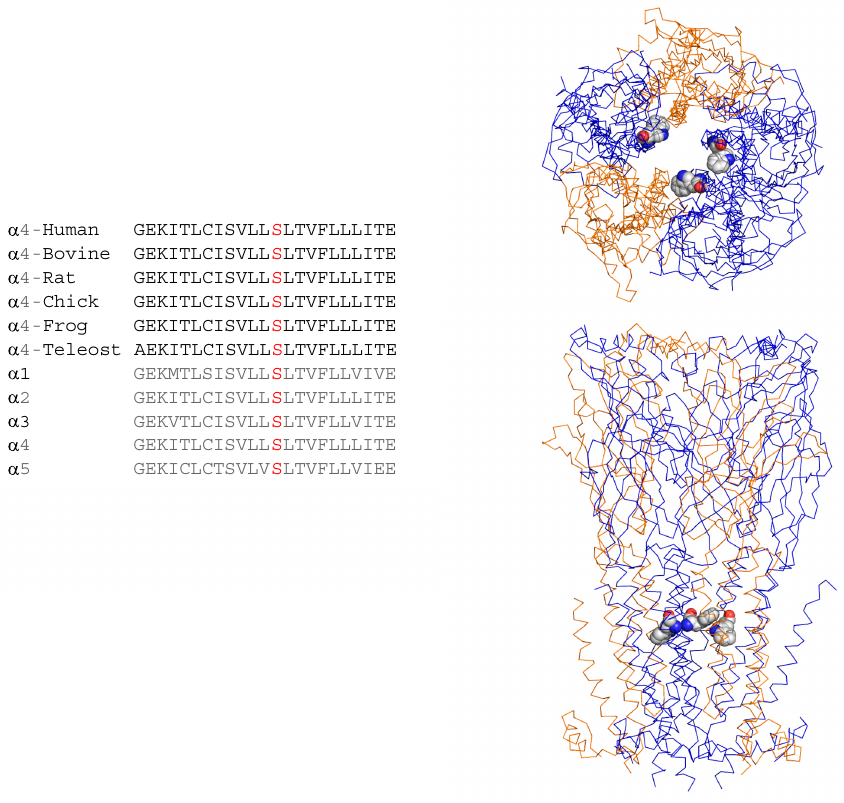
Figure 2. Sequence alignment and location of the α 4-Ser284Trp residue in the structure of the α 4 β 2 nAChR. Upper panel , sequence alignment of the M2 transmembrane domain of the α 4 subunit for different vertebrate species and the indicated human α -subunit subtypes. The α 4-Ser284 residue is highlighted in red font. Lower panel , top and side views of the structure of the ( α 4) 3 ( β 2) 2 stoichiometric form of the receptor (PDB: 6CNK) with the α 4 subunits in blue , the β 2 subunits in orange , and the substituted Trp sidechain at position 284 in space filling